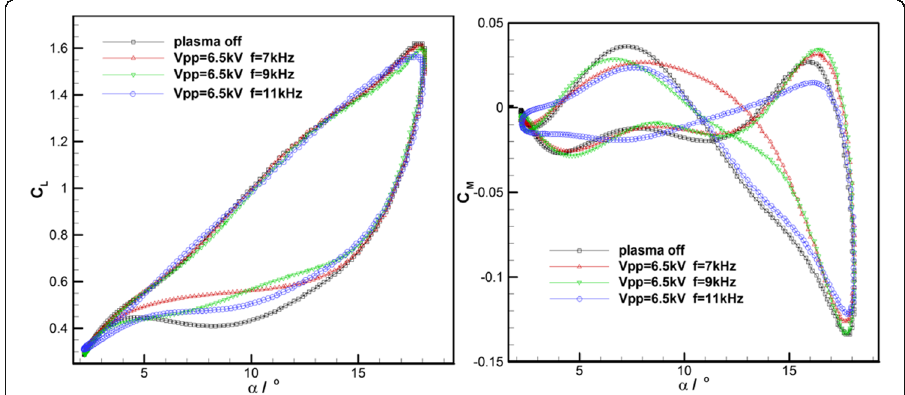
Fig. 3 Dependence of C L and C M on carrier frequencies of steady